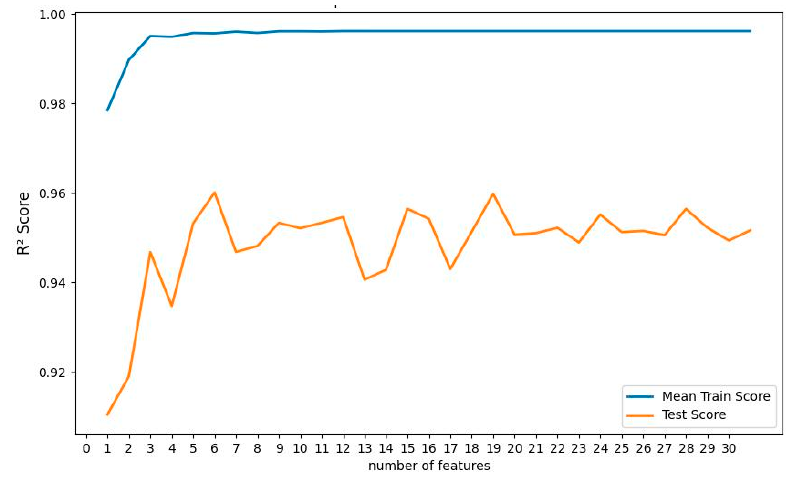
Figure 13. R 2 score for the training set and testing set with the different number of features (ranked) used in DTR.